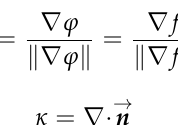
→ x O = ( 0, 0 ) in a structured 50 × 50 mesh.